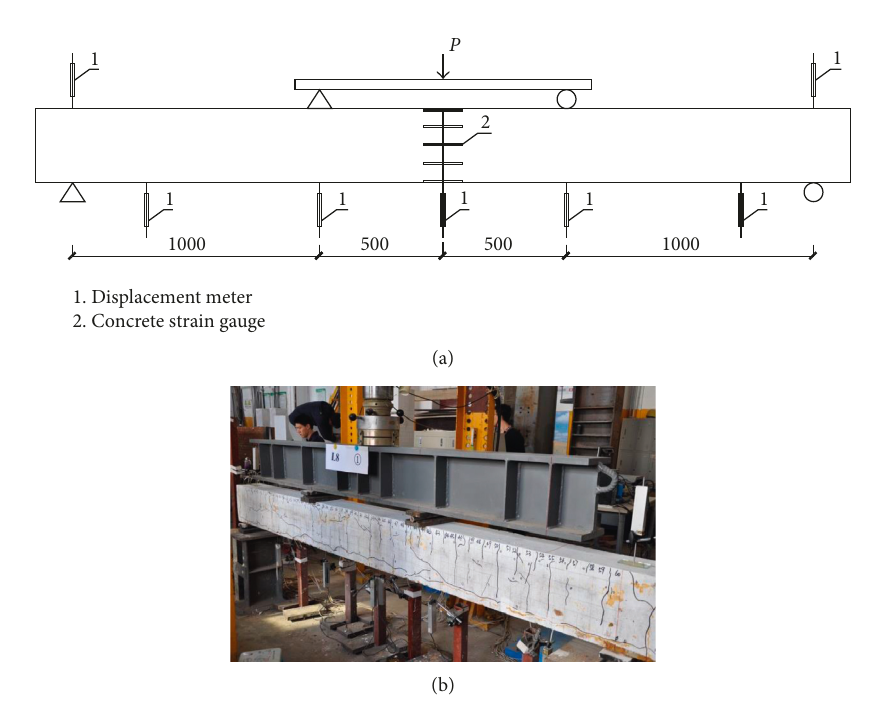
Figure 5: (a) Layout of test setup and measuring equipment (unit: mm). (b) Loading test